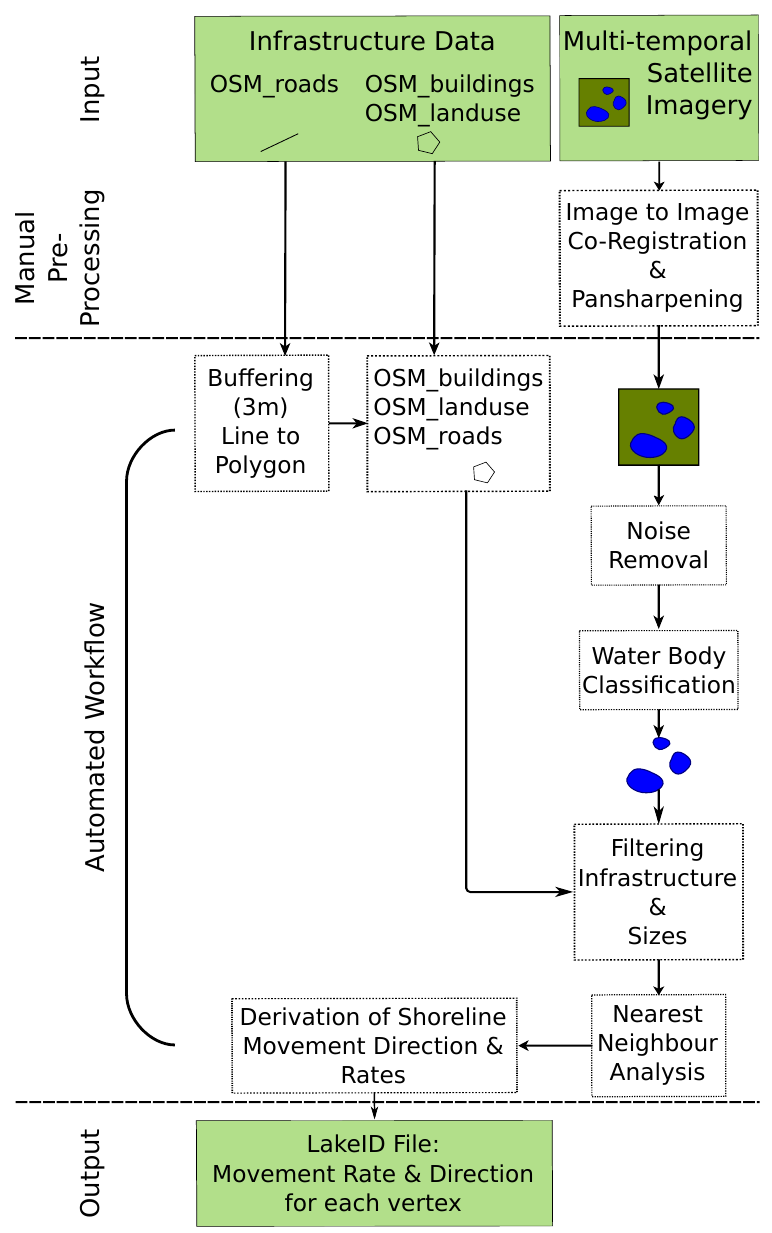
Figure 1. Illustration of all processing steps, subdivided into data input, manual pre-processing and the automated workflow with the resulting output. The automated part consists of (i) the buffering of linear infrastructure elements and merging with polygonal features, (ii) image noise removal, (iii) water body classification and the vectorization of the shoreline geometry, (iv) filtering for a user-defined water body size and elimination of infrastructure elements, (v) nearest neighbor analysis for each vertex and (vi) the subsequent derivation of movement rates and